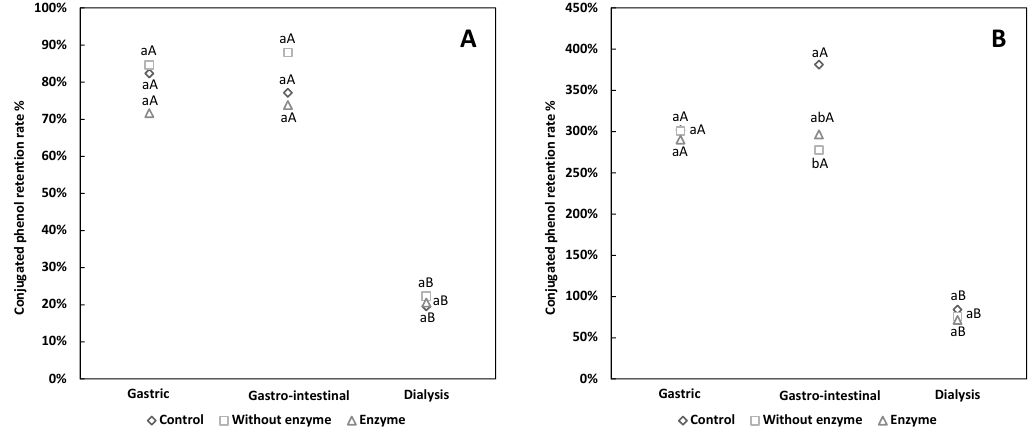
Figure 2. The free phenol retention rate of walnut pigment from brown shell ( A ) and green husk ( B ) subjected to simulated in vitro gastric and intestinal digestion and dialysis (potential uptake). The data presented in this figure consist of average quantities ± SD of three independent samples. Di ff erent letters in the bars within each group represent statistically significant di ff erences ( p < 0.05). “a–c” indicates significant di ff erence in longitudinal, and “A–C” represents significant di ff erence in lateral.